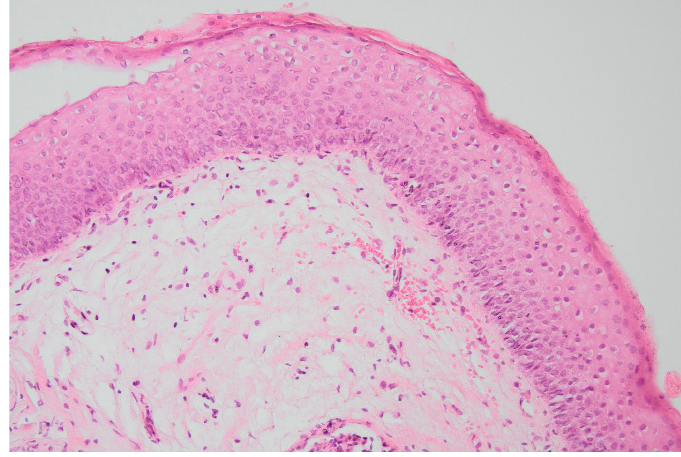
Figure 1. Histopathology examination showing non-keratinizing stratified squamous epithelium. Morning urine samples (sampled from the middle stream) were collected in sterile containers from the 17 studied patients (the day before the cystoscopy was performed), from female members of their families (13 mothers and 2 sisters) living in the same